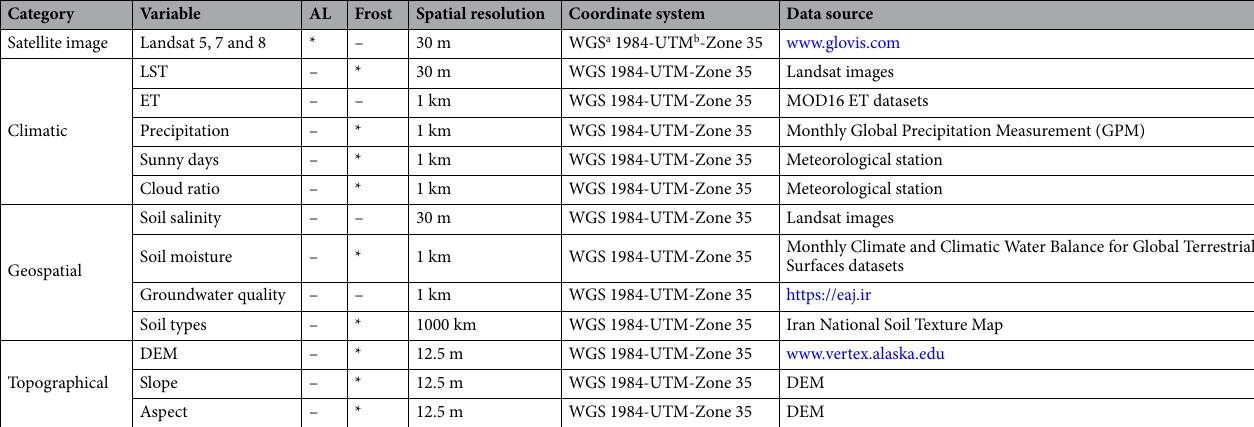
Table 1. Characteristics of predisposing variables used to assess the impact of climate change on the FS. a World Geodetic System. b Universal Transverse